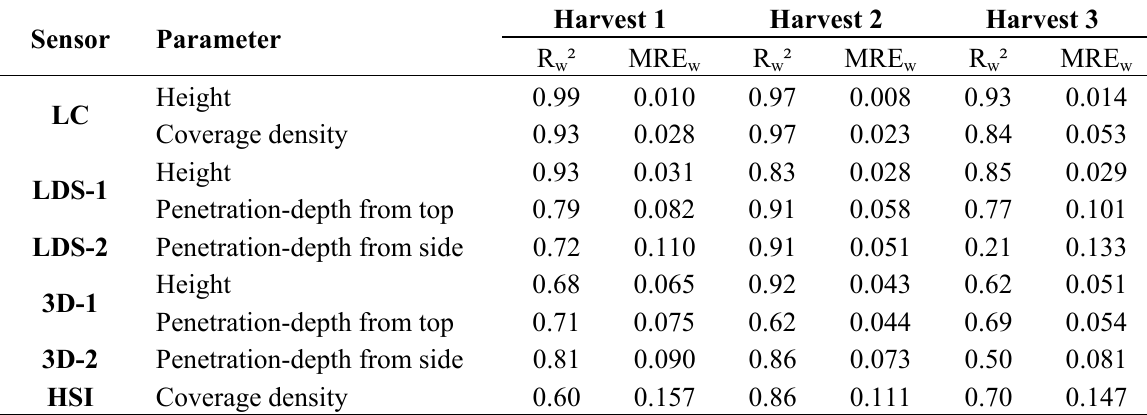
Table 2. Repeatability of processing results by light curtains (LC), laser distance sensors (LDS-1, LDS-2), 3D-Time-of-Flight cameras (3D-1, 3D-2) and hyperspectral imaging (HSI) for three different development stages of the plants from the years 2011 and 2012 based on two repetitions of 400 samples for every development